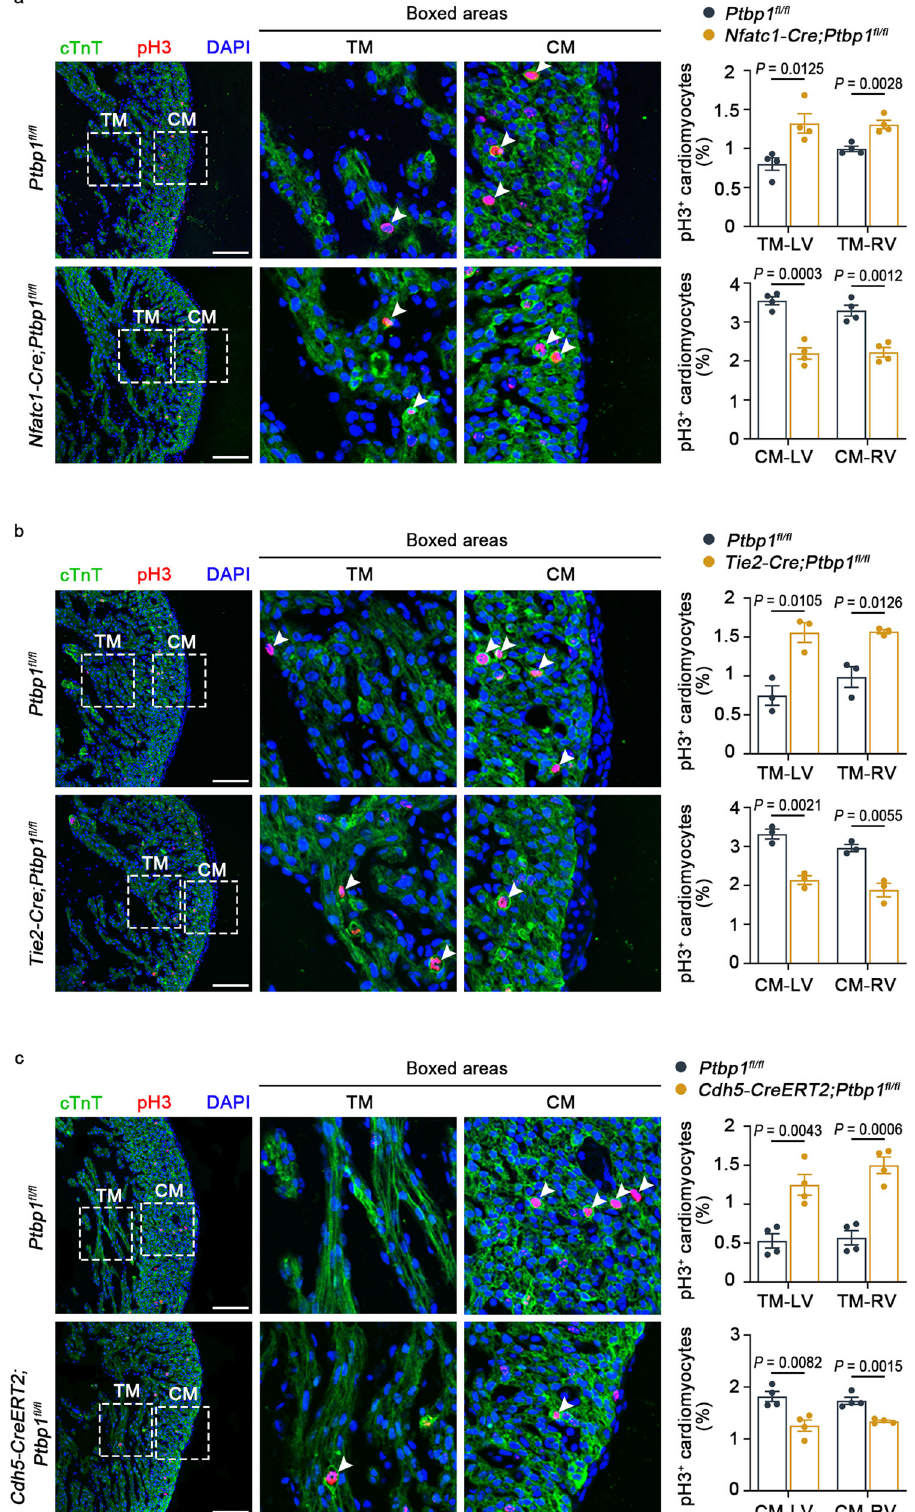
Fig. 4 | The proliferation of cardiomyocytes is disrupted in Ptbp1 knockout mice. a – c Co-immunostaining of the cell proliferation marker pH3 (red) and car- diomyocytemarkercTnT(green)showsdisruptedproliferationofcardiomyocytes in heart sections from E13.5 Nfatc1-Cre ; Ptbp1 fl / fl ( a ), E13.5 Tie2-Cre ; Ptbp1 fl / fl ( b ) and E15.5 Cdh5-CreERT2 ; Ptbp1 fl / fl ( c ) mice, respectively. n =4 miceper group in ( a ), n =3 mice per group in ( b ), n =4 mice per group in ( c ). Scale bars, 100 µ m. The graph